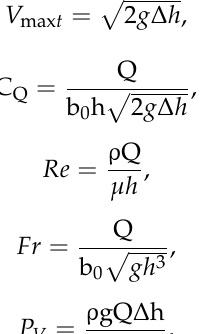
Table 2. Main hydraulic characteristics obtained in all simulations.